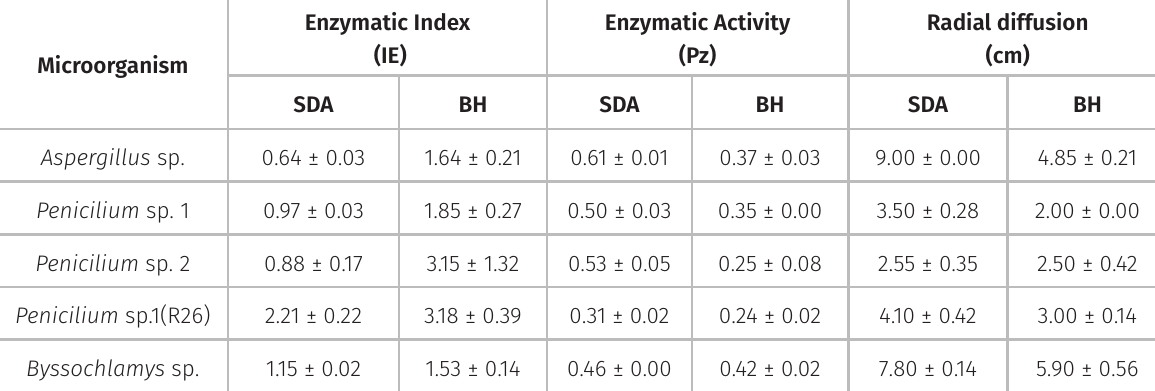
Table I. Average and standard deviation of the enzyme index and enzymatic activity of strains for MnP in solid medium in 15 days of incubation.